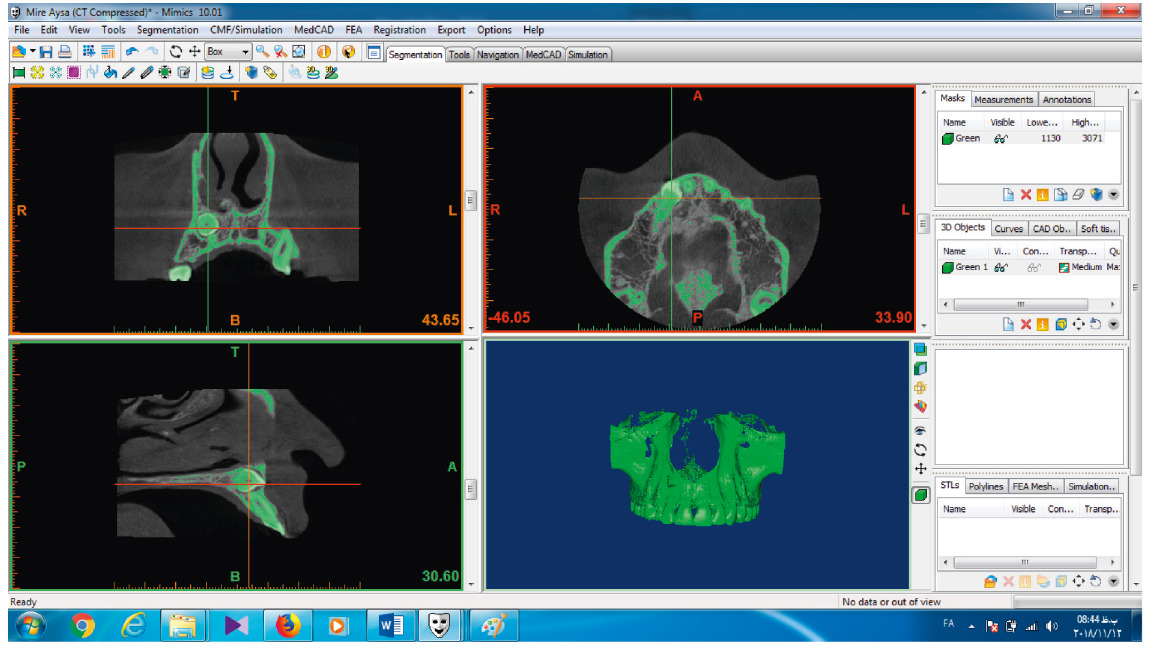
Figure 1: Lateral tooth and surrounding tissues isolated with